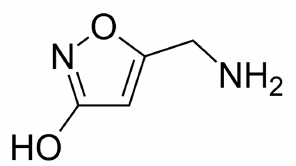
Figure 7. Structure of ibotenic acid.